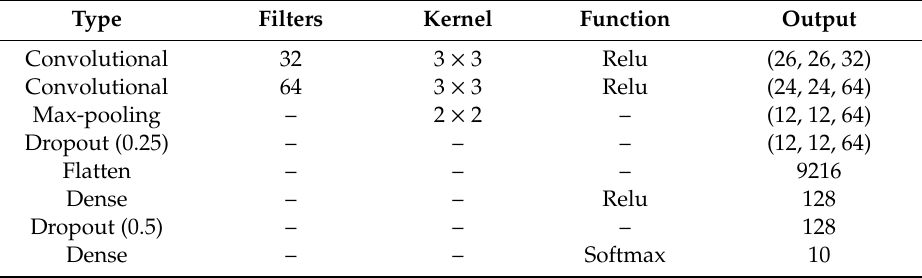
Table 3. Convolutional neural network (CNN)